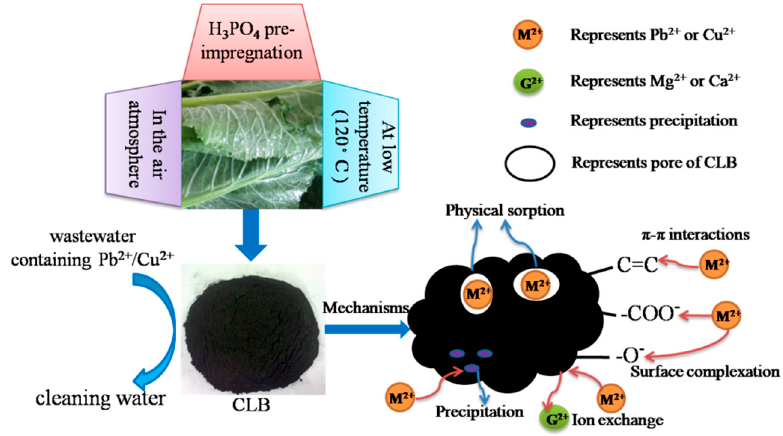
Figure 6. Summarized preparation process and mechanism of Cu(II) and Pb(II) sorption onto CLB.